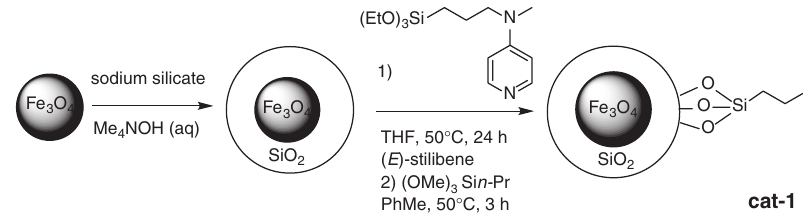
Scheme 1 Preparation of DMAP catalyst cat-1 .